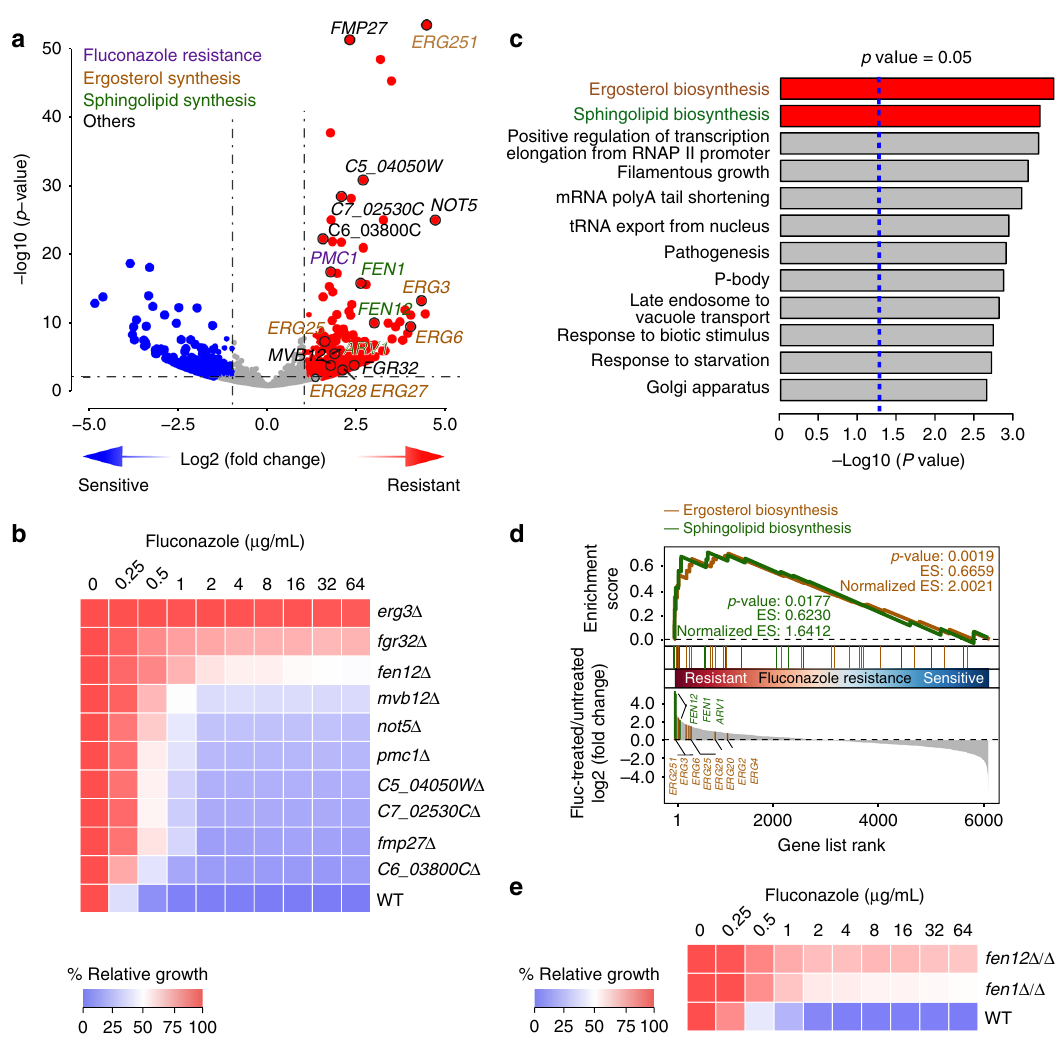
Fig. 4 Genetic screens for fl uconazole-resistant mutants. a Volcano plot of fold changes of genes with PB inserts in PB transposition mutants grown in media containing 100 µ g/mL fl uconazole in comparison with the same mutants grown in normal media. p -Values were calculated using the Wald test. Ten candidates selected for phenotype con fi rmation are indicated. Genes known to be associated with fl uconazole resistance and ergosterol and sphingolipid biosynthesis are shown with different colors. b Gene deletion of 10 candidates randomly selected from the top-ranked genes in a con fi rms increased resistance to fl uconazole. Fluconazole susceptibility was evaluated using the standard CLSI broth microdilution protocol 67 . Cultures were incubated for 24 h, and growth was measured as OD 600 and expressed as a percentage of the growth in the control wells with no drug (DMSO alone) for each strain. c Gene Ontology (GO) analysis of the PB -mutated genes that led to statistically signi fi cant fold increases ( p < 0.05) after fl uconazole treatment. Red bars highlight the ergosterol and sphingolipid biosynthesis pathway. p -Values were from Fisher ’ s exact test. d Gene Set Enrichment Analysis (GSEA) of the NGS data from a . p -Values were determined using the Kolmogorov – Smirnov test. e Homozygous deletion of FEN1 or FEN12 in BWP17 also results in increased fl uconazole resistance. The assay was done as described in